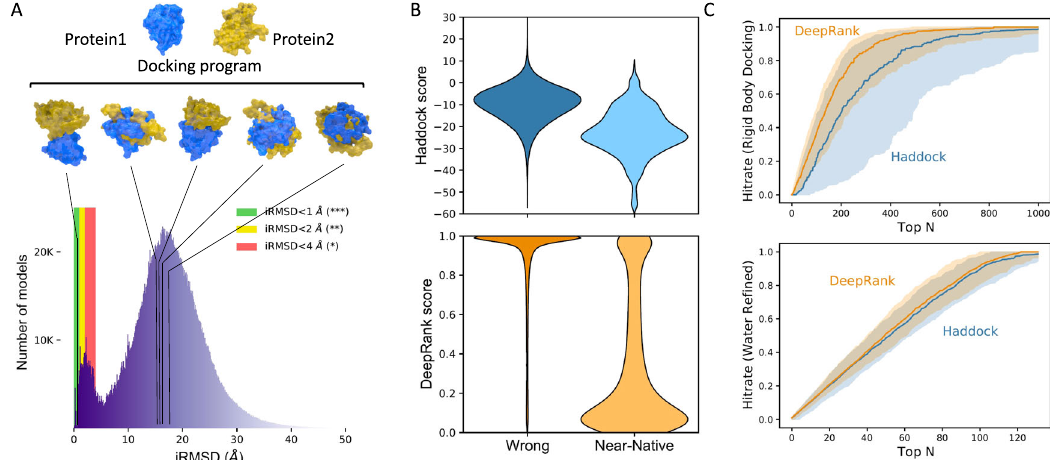
Fig. 3 DeepRank applied to the docking scoring problem. A Top: Using a docking software (e.g., HADDOCK 36 ) a large number of docking poses between two proteins (here PDB ID: 1AK4) are generated. Bottom: Distribution of iRMSD (interface root mean squared deviation) values obtained for the docking benchmark 5 32 using HADDOCK in fi ve docking scenarios (see Methods). Most conformations (93%) are wrong with iRMSD values larger than 4 Å and only less than 1% of the conformations have iRMSD values lower than 1 Å. B Distribution of the DeepRank and HADDOCK scores for the wrong models and near-native models from the rigid body docking stage. The lower the score the higher likelihood a model is predicted to be a near-native model. C Performance of DeepRank on the BM5 set compared to HADDOCK ’ s scoring function. This data represents the predictions of both methods on 140 distinct test cases considered during the 10-fold cross-validation. Each individual test case contains about 3000 conformations of a single complex. The thick line marks the median of the Hit Rates (see Methods) calculated for individual test cases and the shaded area marks the 25 – 75% quantile interval. The data is shown up to the top 1000 (see Supplementary Fig. 6 for the full-range plot). Top: Rigid-body docking models only; Bottom: Water re fi ned models only. HADDOCK uses different scoring functions for models generated in different stages: rigid-body, fl exible-docking, and water- re fi nement stages (see